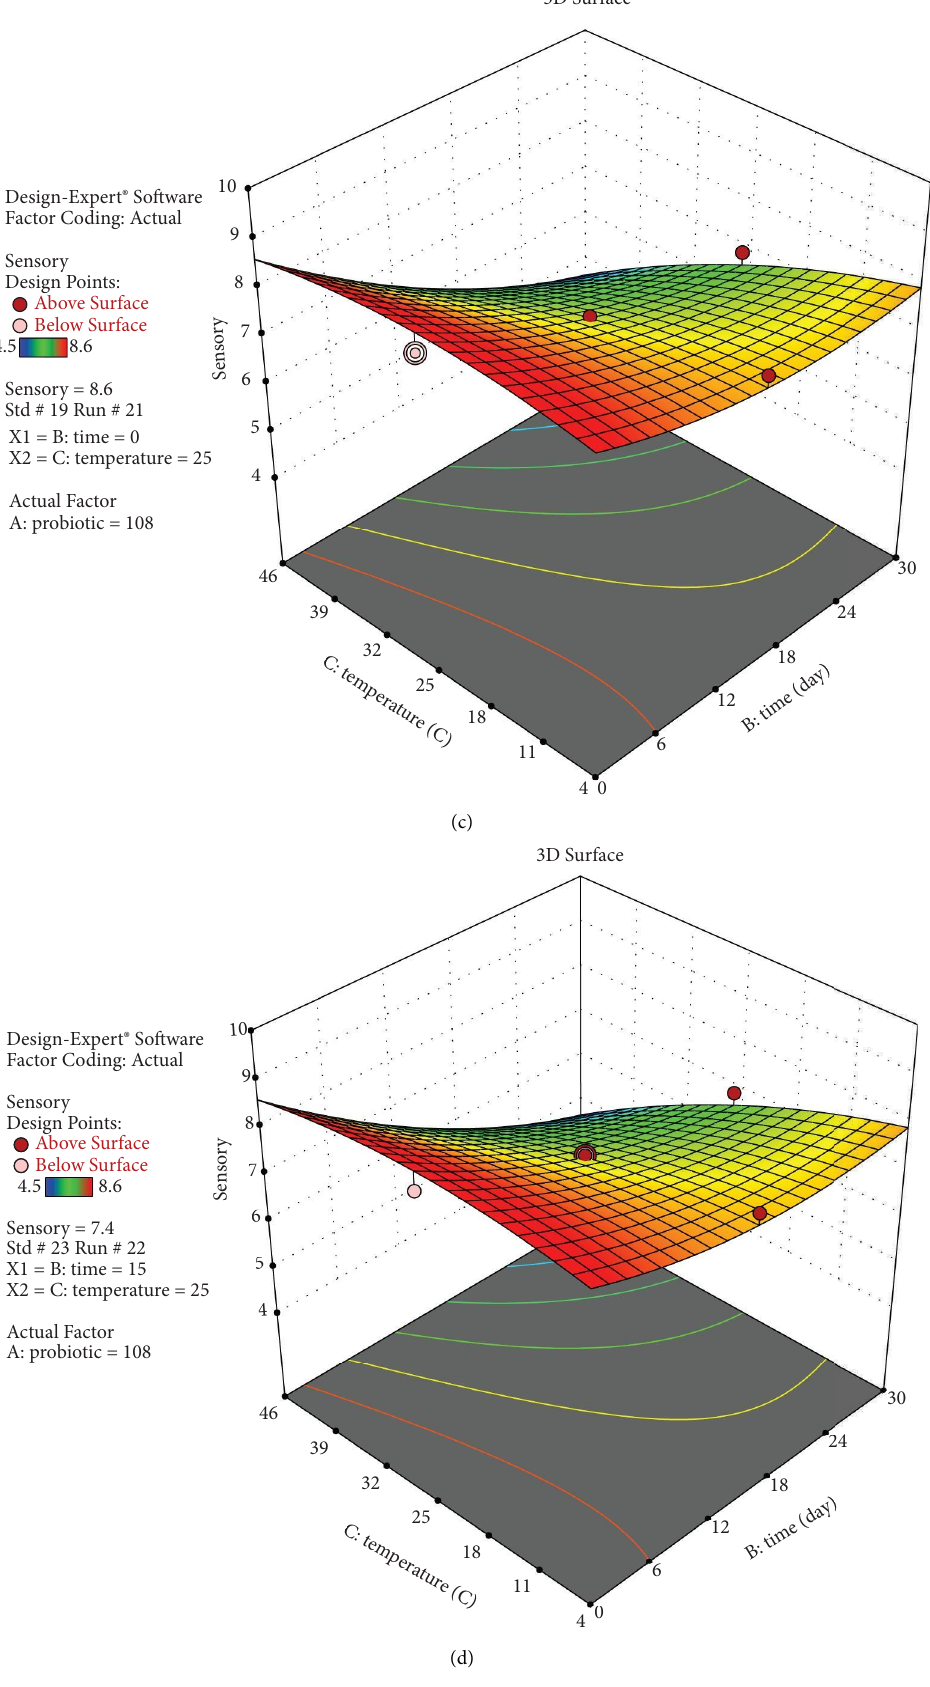
Figure 9: Te efect of probiotic content (10 8 CFU/g) on the overall acceptance of pistachio